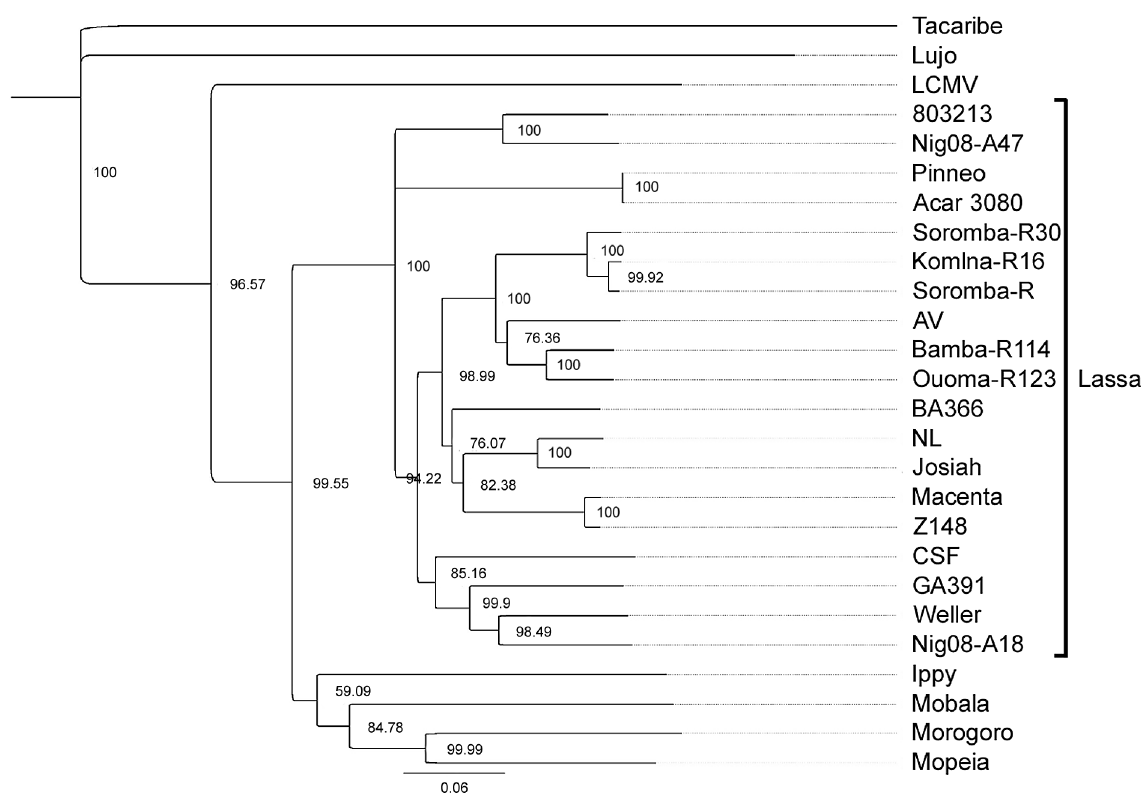
Figure 3. Phylogenetic analysis was conducted on full-length sequences for the glycoproteins using the Jukes-Cantor Neighbor- joining method with 10,000 bootstrap replicates. Sequences from the five Malian isolates were compared to the arenavirus sequences outlined in figure legend 2.